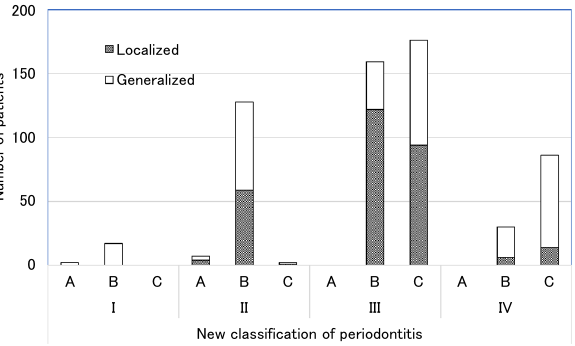
Figure 1. Distribution of periodontitis patients according to the new 2018 classification of periodontitis.